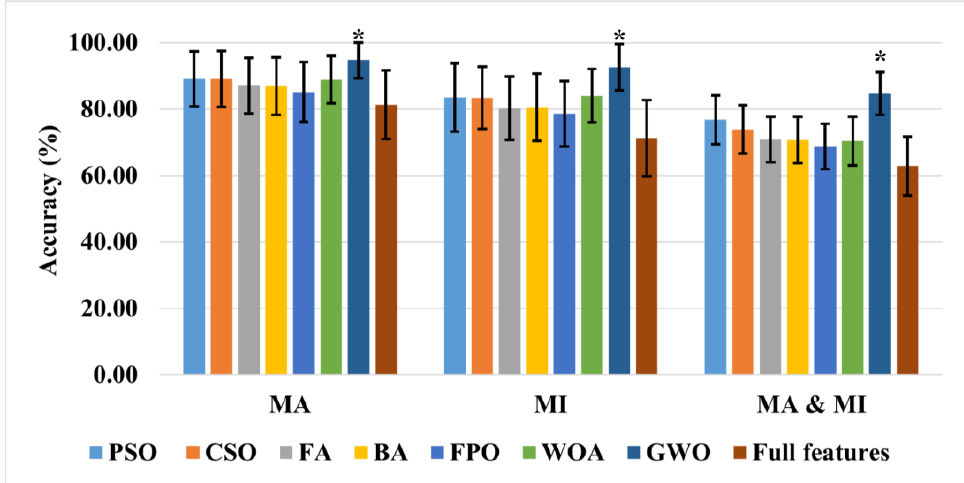
Figure 4. Comparison of all the presented metaheuristic algorithms and all the channel features for the various tasks (data represented as the mean ± the standard deviation). * p < 0.01. Table 5. Average feature vector size and processing time of the optimization algorithms.